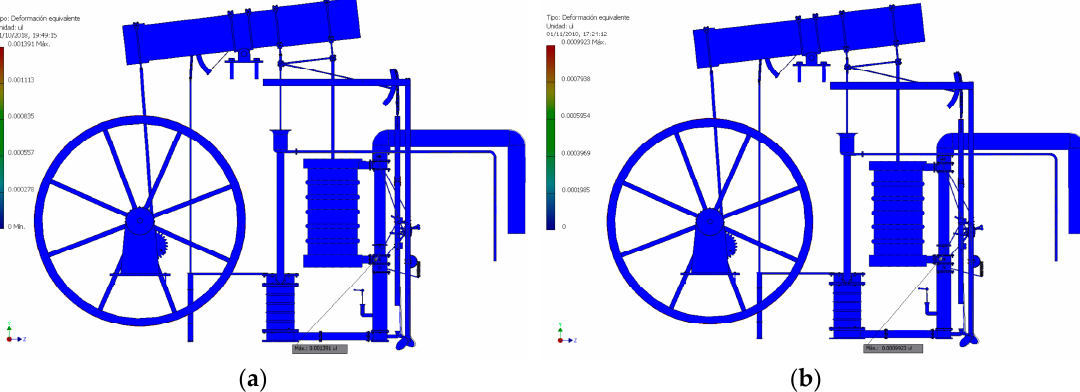
Figure 20. Equivalent deformations: ( a ) downward movement and ( b ) upward movement.